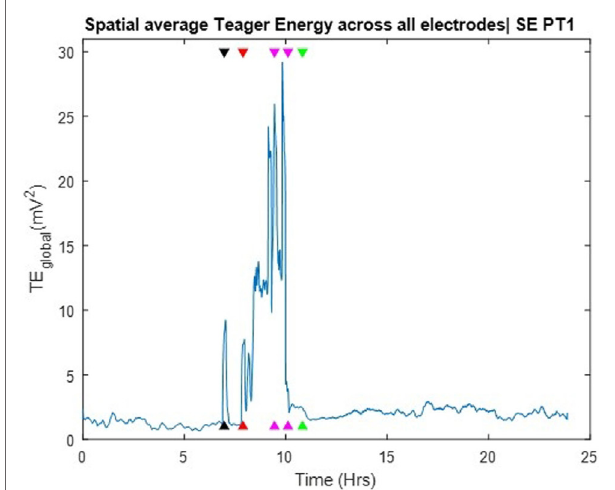
FigUre 2 | Left panel: Intracranial electroencephalographic (EEG) recording from patient PT1 at the onset of status epilepticus (SE) in the mid insular electrodes (one red arrow) and anterior insular electrodes (two red arrows) followed by propagation to superior temporal gyrus (STG) and orbitofrontal regions (three red arrows). Right panel: Intracranial EEG recording 5 min after the onset of SE with continuous seizure activity in insula and STG, and the onset of spread to the middle temporal gyrus (orange arrow). The EEG records are illustrated with a 10 mm/s time base, sensitivity 50 µV/mm, and filtered between 1 and 100